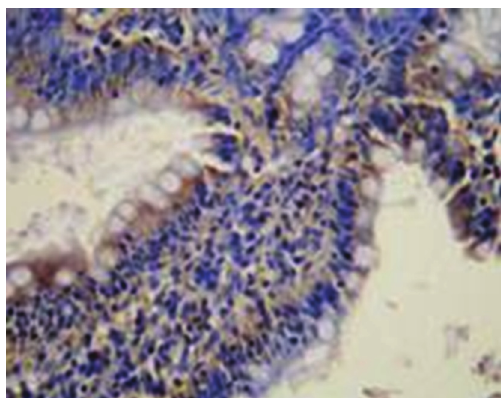
Figure 9: Model control group-21d mucous membrane of small intestine (++) Bax × 200.